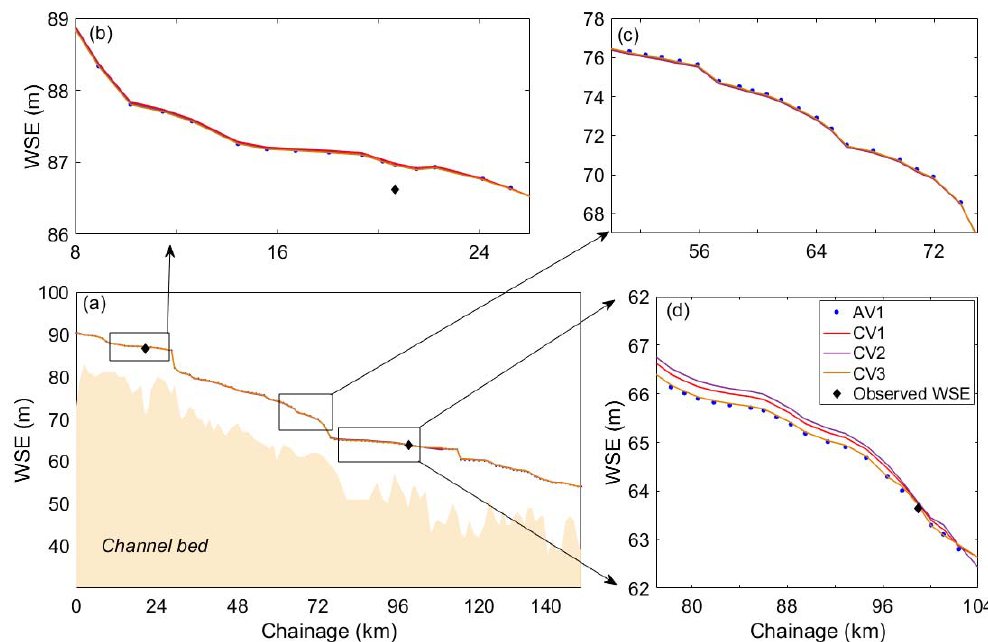
Figure 9. WSE profiles along the river reach obtained by the configuration C. ( a ) The WSE profiles at the flood event. ( b–d ) zoom-in of ( a ) focusing on the three different reaches.